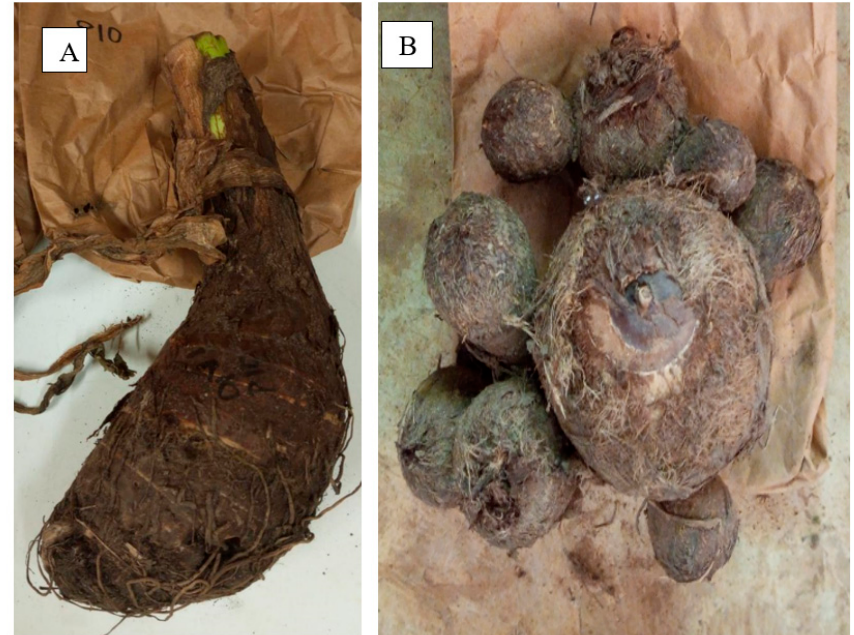
Figure 4. Corm of C. esculenta . ( A ): dasheen type; ( B ): eddoe type. Photographed by the first author on 25 December 2021 ( A ) and 15 January 2022 ( B ) during a visit to a farm in Sabo, Ogbomoso North, Oyo State, and Ilasa, Ekiti East, Ekiti State, Nigeria, respectively. The corm type shown in ( A ) is popularly known as “Kokooghana”, while that in ( B ) is popularly known as “Eposo”.